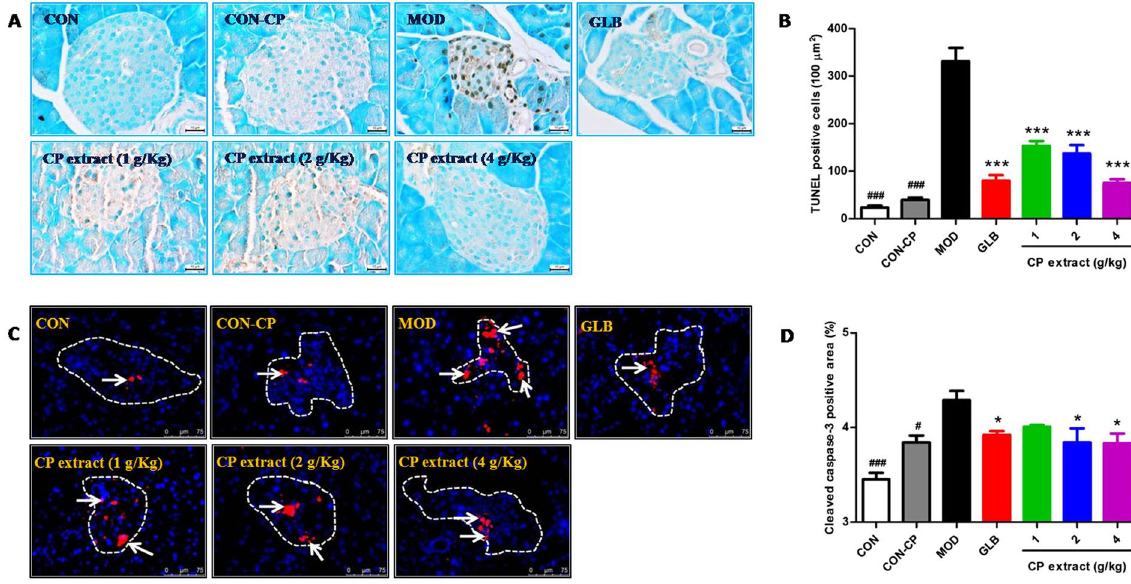
Figure 3. CP extract suppresses pancreatic β cell apoptosis in diabetic mice. The type 2 diabetic mice were induced by feeding with high-fat diet for 4 weeks and then injecting intraperitoneally with 25 mg/kg STZ for 3 days consecutively. The diabetic mice with consecutive 7-day hyperglycemia (11 mmol/L or greater) were selected for the experiment and then CP extract or glibenclamide were administered to mice for consecutive 5 weeks. At the end of experiment, mice were sacrificed. The samples of pancreas tissues were collected. ( A ) TUNEL staining of mice pancreas tissues (magnification, 600 × ) and ( C ) Immunofluorescence analysis of cleaved caspase-3 expression in mice pancreas tissues (magnification, 600 × ); ( B ) The number of TUNEL- positive cells; ( D ) Cleaved caspase-3-positive area. All data are presented as means ± SEM (n = 8). # p < 0.05, ## p < 0.01 and ### p < 0.001, diabetic model group compared with non-diabetic groups; * p < 0.05, ** p < 0.01 and *** p < 0.001, compared with diabetic model group. CON: non-diabetic control group; CON-CP: CP extract- treated non-diabetic control group; MOD: diabetic model group; GLB: glibenclamide-treated diabetic